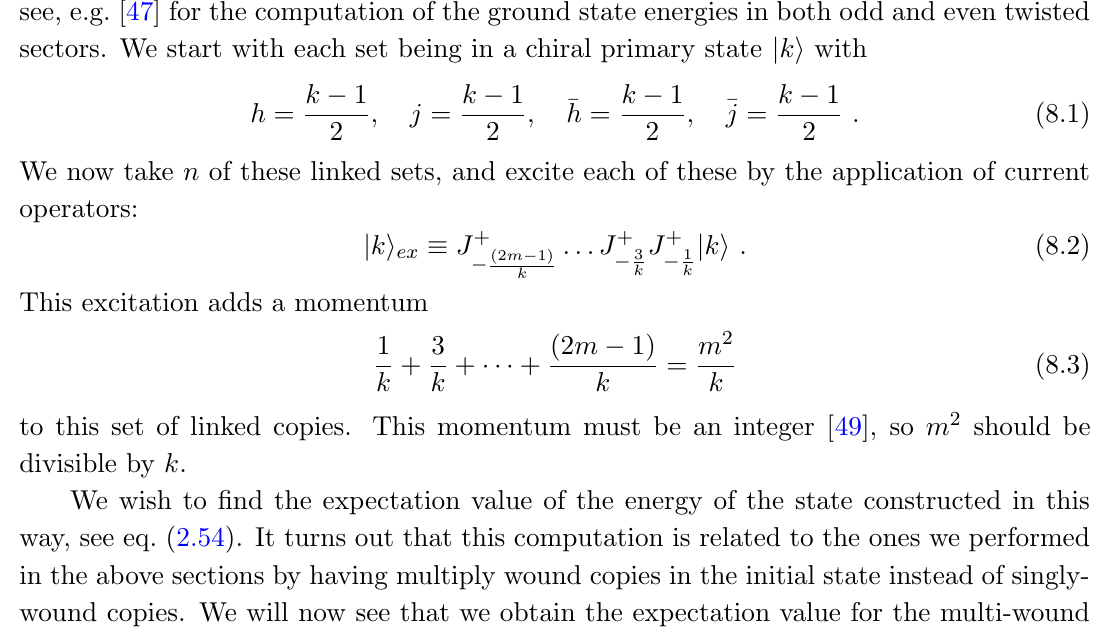
operator J (+ ;m ) (eq. (5.2)) which is composed of m currents. We note that N = 2 and n = 1 corresponds to the case studied in section 5, see eq.